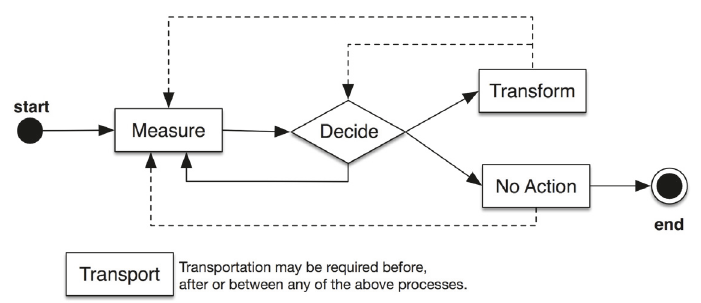
Figure 4: Healthcare functional model concept of healthcare system processes . Solid lines represent typical process sequences and dotted lines represent possible process